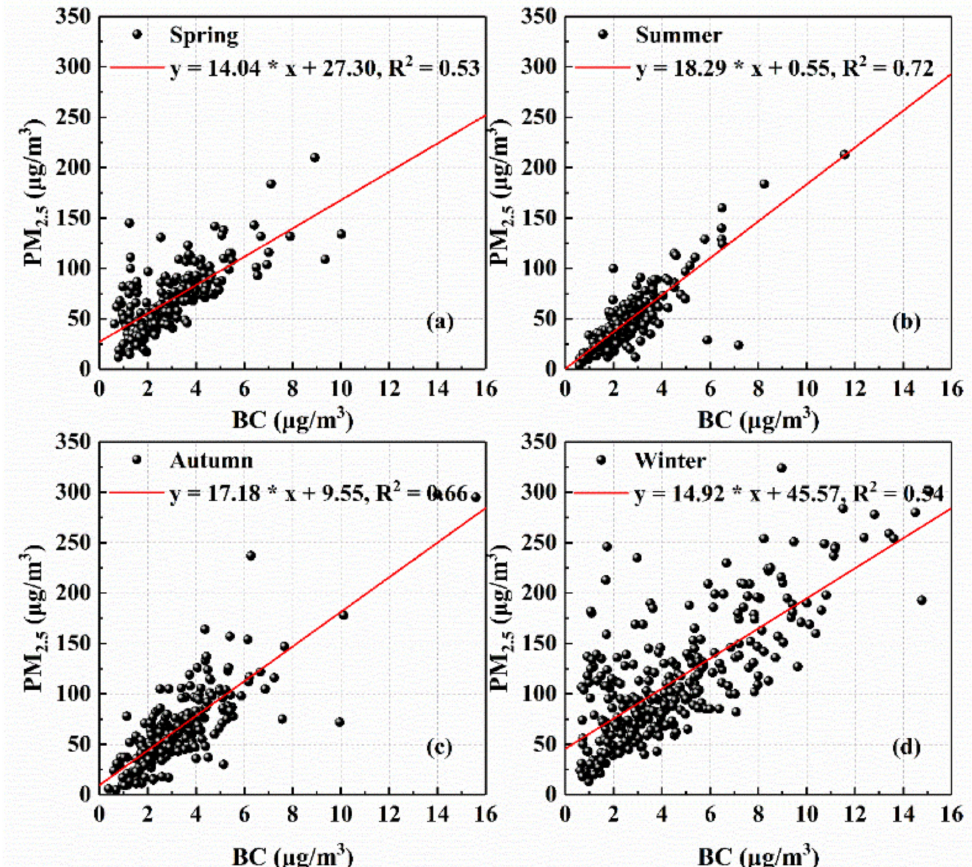
Figure 3. Relationship between the mass concentration of BC and PM 2.5 in ( a ) spring; ( b ) summer; ( c ) autumn; ( d ) winter over Wuhan from 2013 to 2016. The red lines in the plots represent the linear